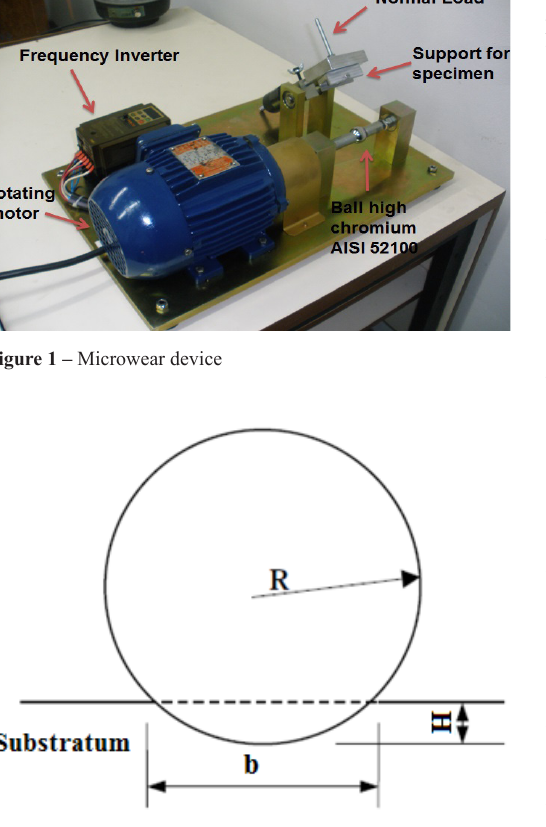
Figure 2 – Circular depression geometry (wear scar) produced in microabrasive wear test